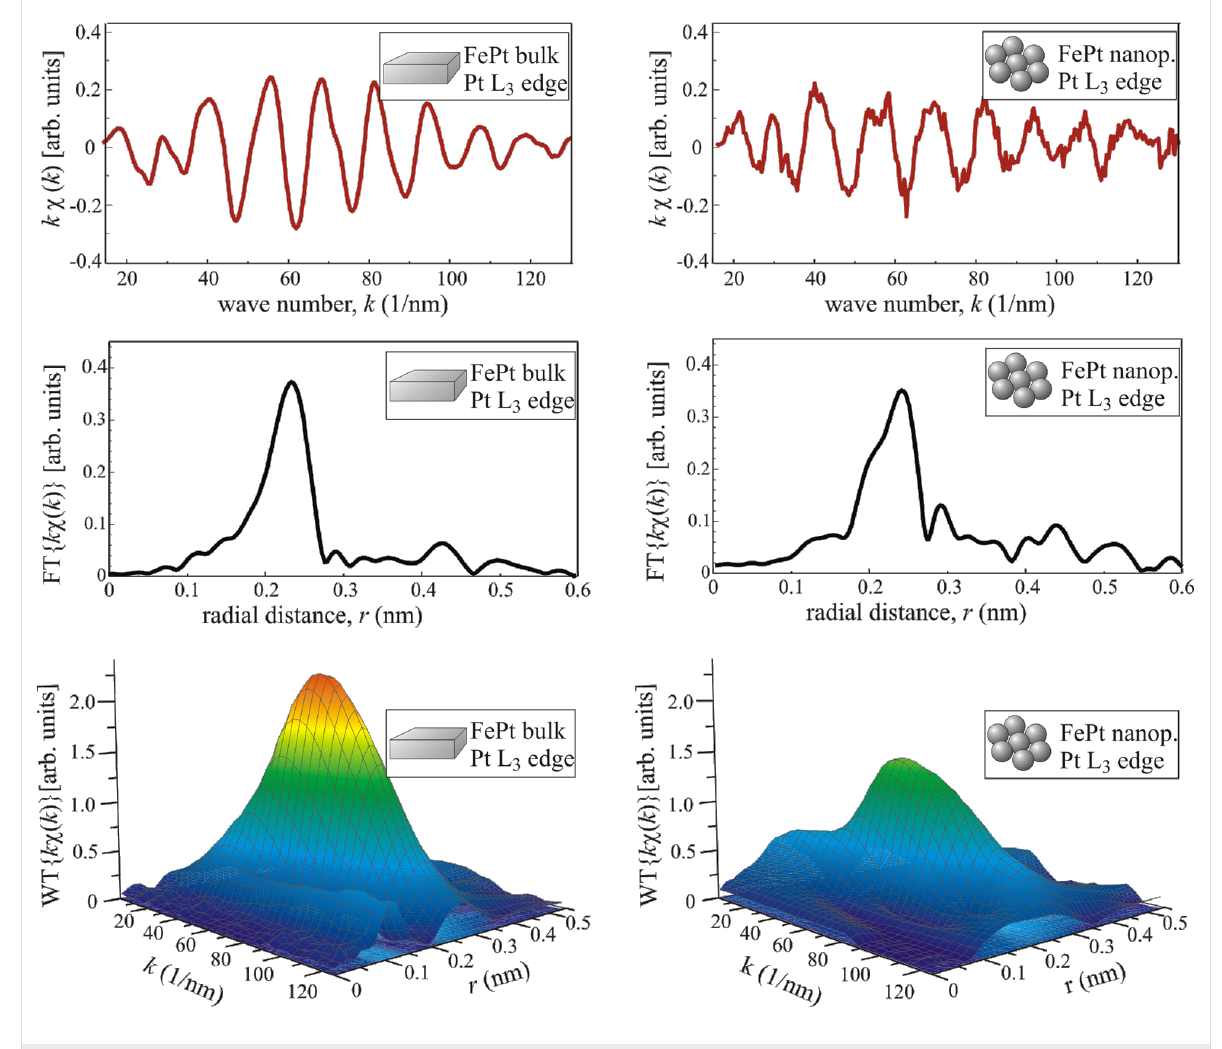
Figure 6: Room temperature EXAFS data of FePt bulk material (left panel) and nanoparticles (right panel) measured at the Pt L 3 absorption edge, their Fourier transform, and wavelet transform.